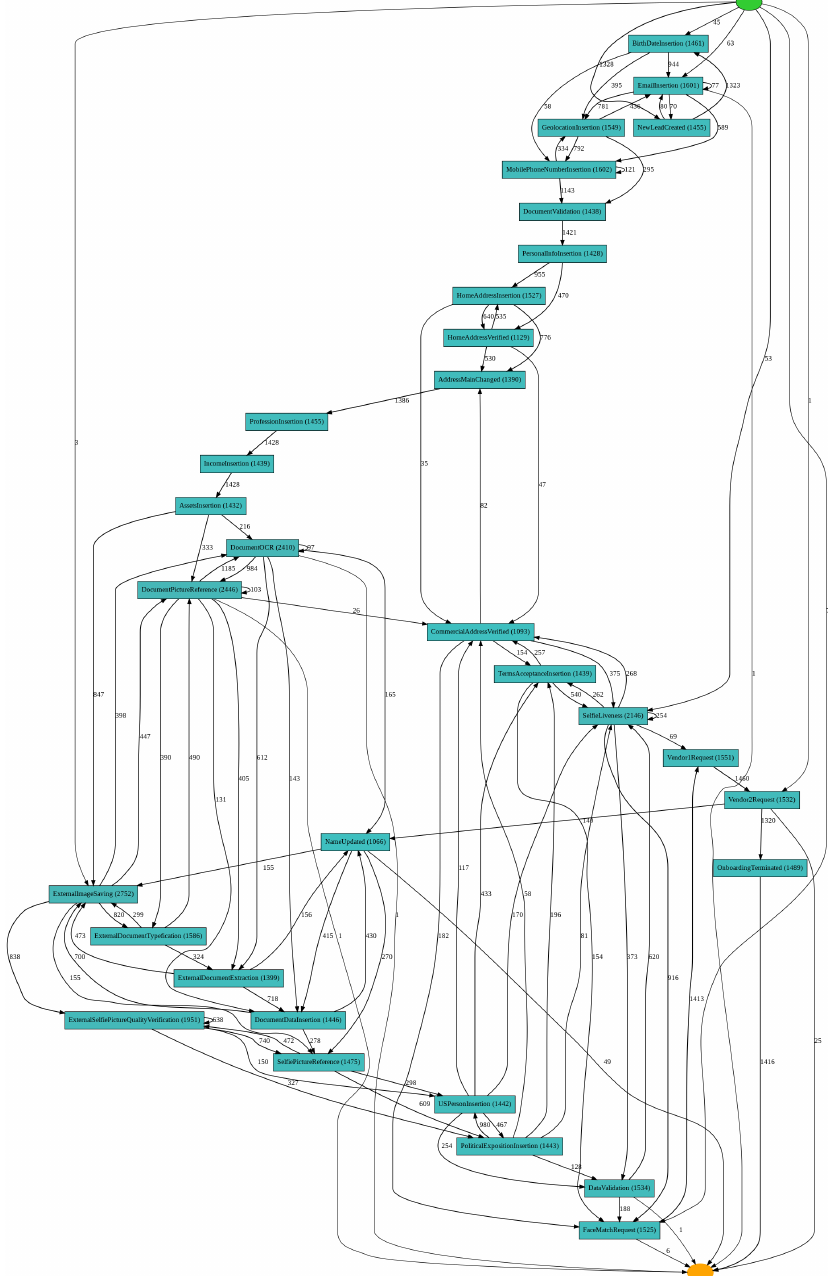
Figure 2. Onboarding process discovered with the heuristic miner